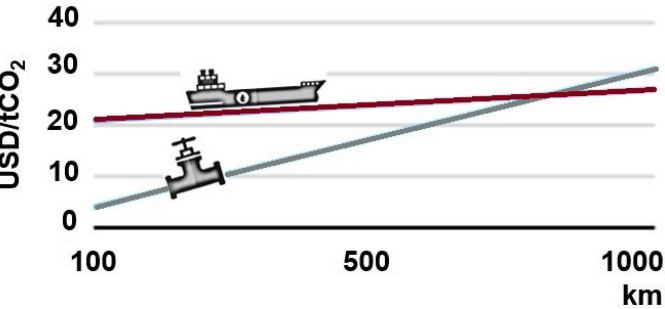
Figure 2. CO 2 transportation cost (adapted from [7]).